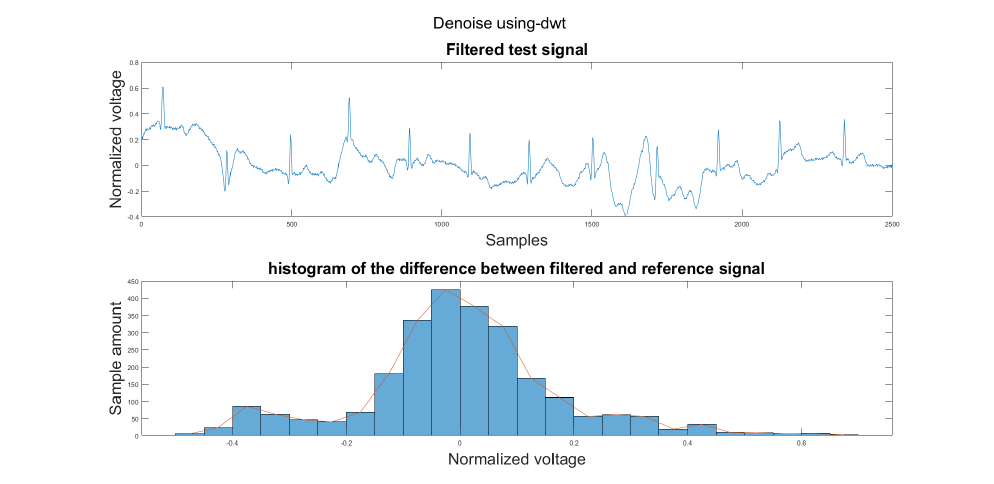
Figure A3. (1) Test signal, (2) histogram of the difference.